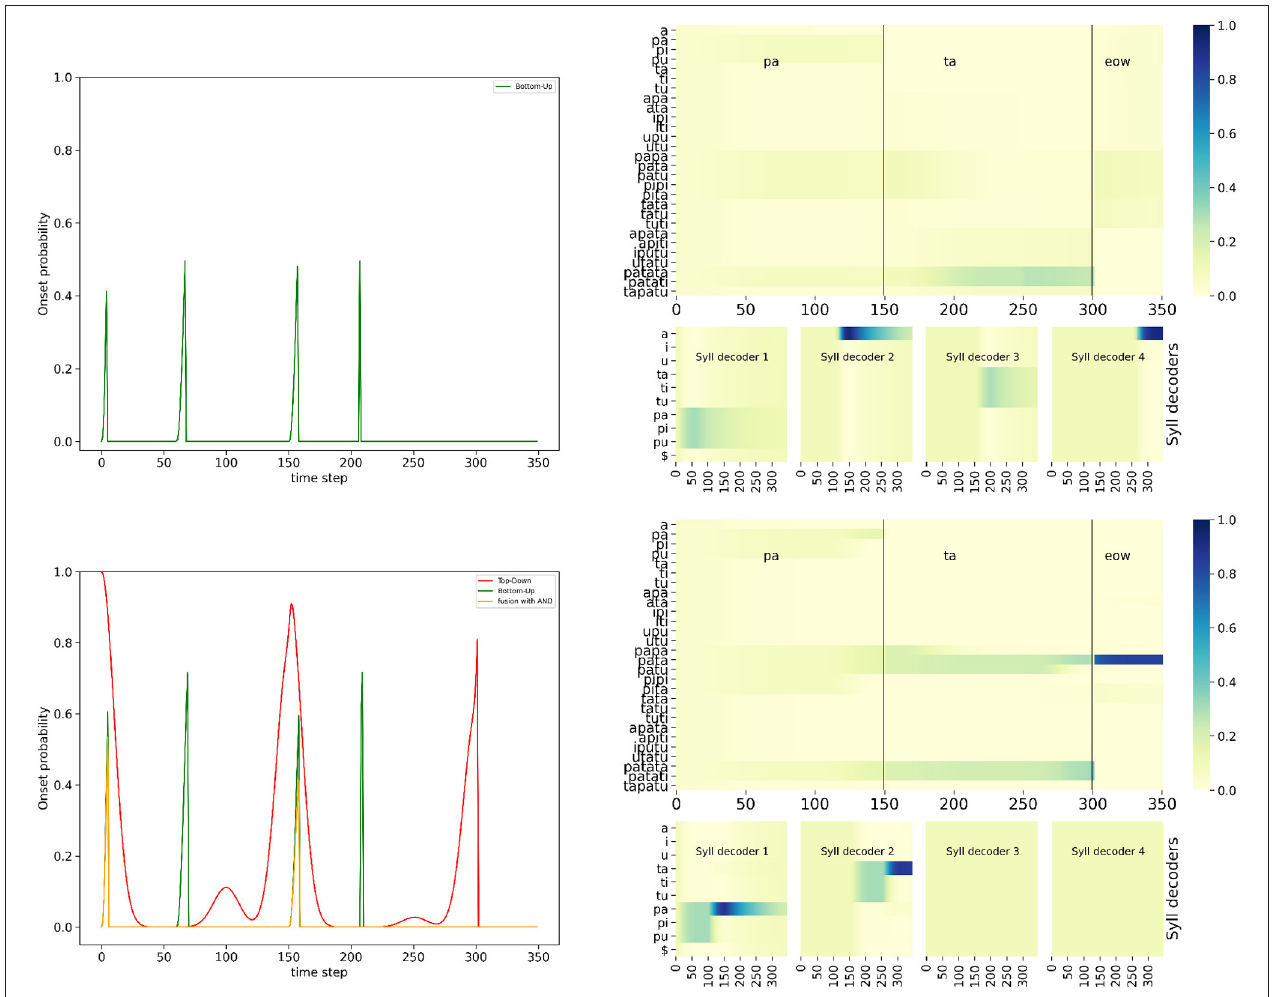
FIGURE 7 | Example of simulation of the “BU-only” variant (top row) and the full model, with the AND fusion model (bottom row) , in the noisy-event condition, on input word “pata.” (Left column) : plots of onset detection probabilities; (Right column) : plots of word probabilities in the word decoder (top row) and syllable probabilities of the syllable decoders (bottom row) . Graphical content is presented in the same manner as in Figure 6 (except that onset probabilities are superposed in a single plot and the phone decoders are not